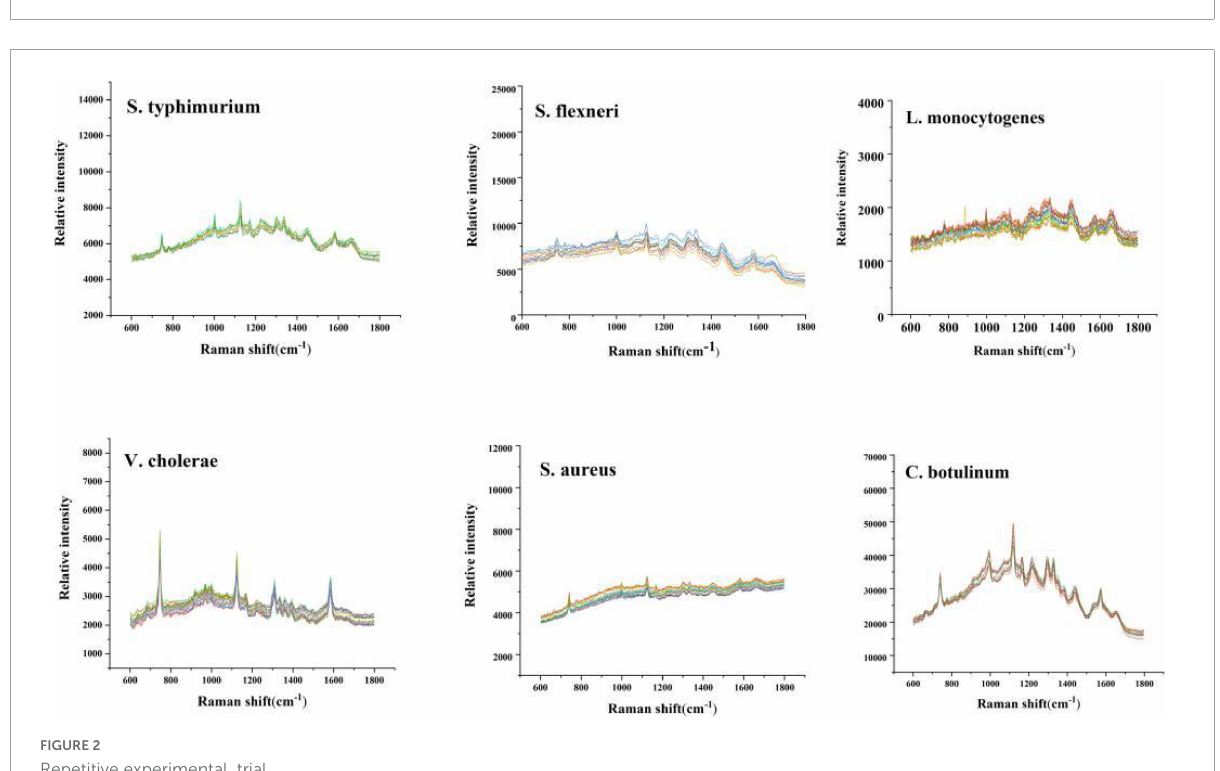
FIGURE2 Repetitive experimental